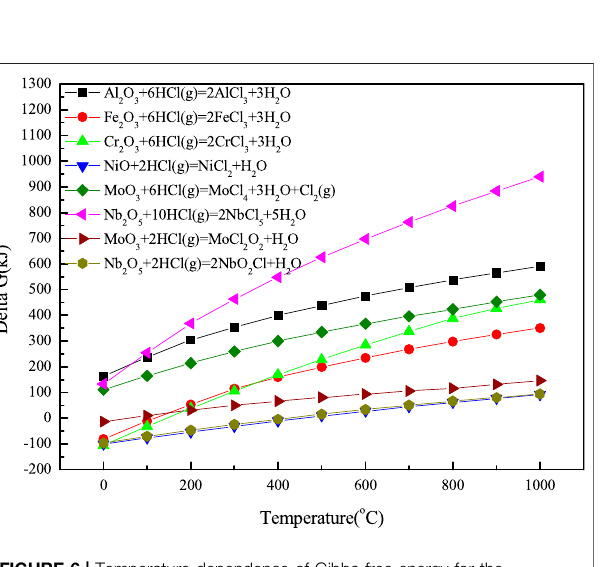
Frontiers in Materials |